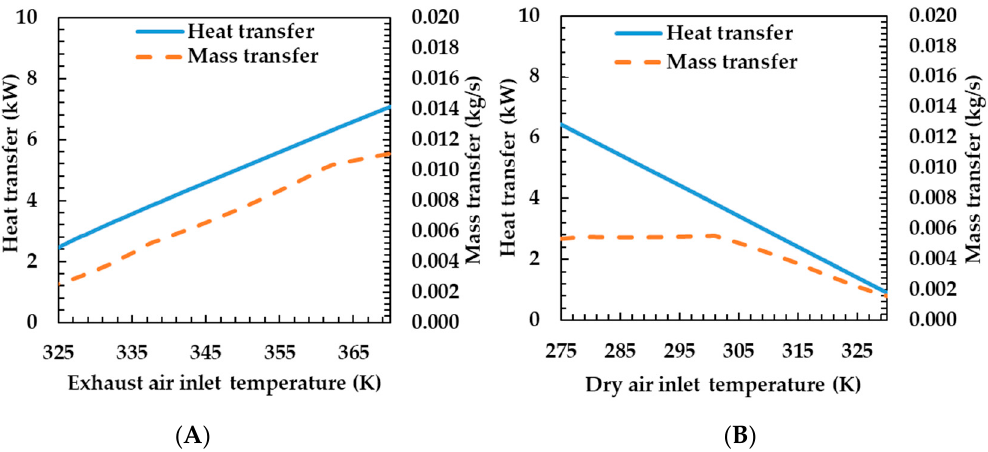
Figure 8. Effects of exhaust air ( A ) and dry air ( B ) temperature on heat and mass transfer rates of the porous metal foam